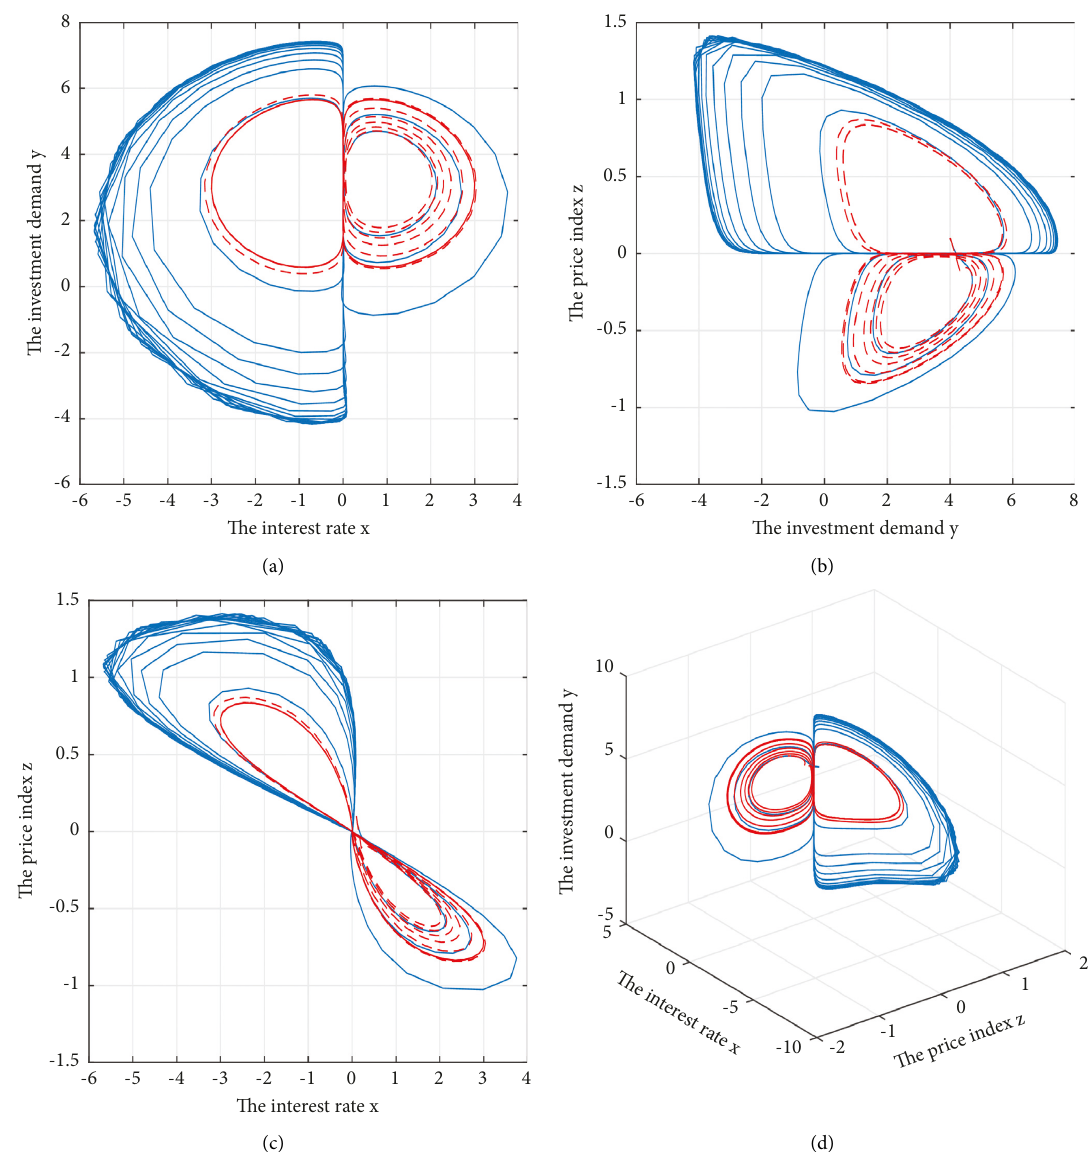
Figure 8: The phase portrait of the proposed model where (a) the demand of investment versus the rate of investment, (b) the index of price versus the demand of investment, (c) the index of price versus the rate of investment, and (d) the chaotic behaviour of the system with a � 3 . 0 ,b � 0 . 1 , c � 2 . 0, and ϑ � 0 . 5 to identify the influence of these input parameters on the chaos of the